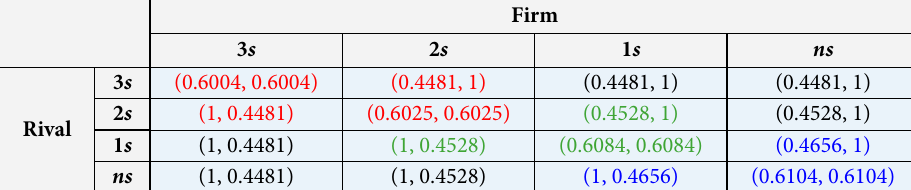
Table 8. Technological transition: four observations, risk-averse DM, and signals on X 1 Firm 3 s 2 s 1 s